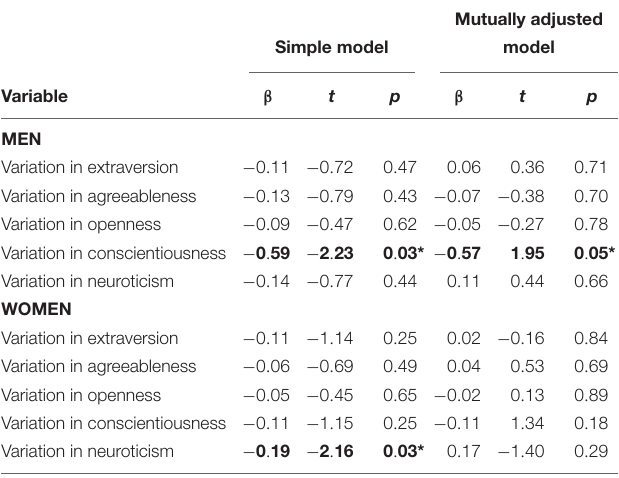
TABLE 4 | Group bonding and group heterogeneity in personality, N = 164. Mutually adjusted Simple model